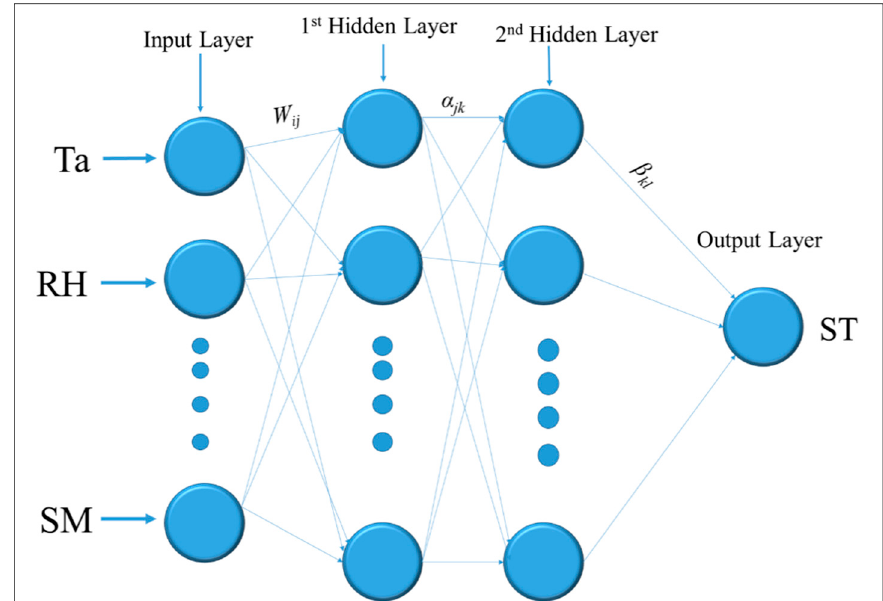
Figure A1. The structure of MLP. Ta, RH, VPD, and SM are air temperature, relative humidity, vapor